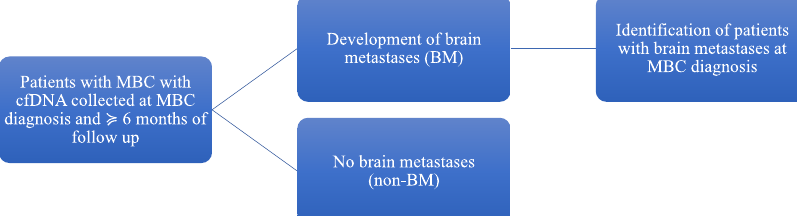
Fig. 1 Consort diagram of study cohorts. In this study, patients with MBC with cfDNA collected at MBC diagnosis with ≥ 6 months of follow up were analyzed for the development of brain metastases (BM). Those patients who had BM at diagnosis of MBC were also identi fi ed. Table 1. Characteristics of patients with brain metastases (BM) versus those without brain metastases (non-BM).